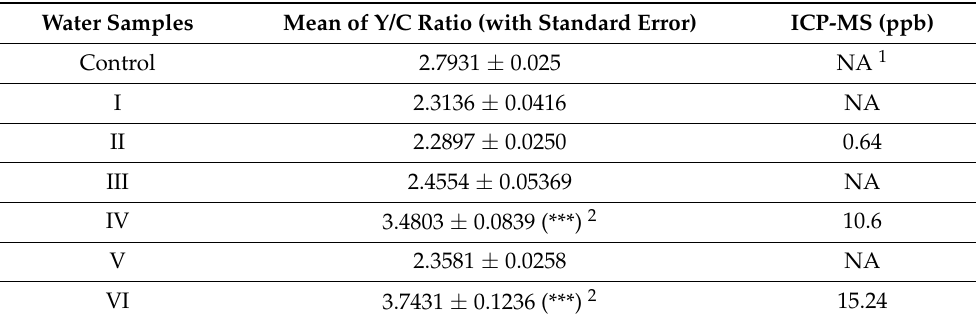
Table 2. Pb detection in different water supply systems. pMet-lead FRET ratios of practical Pb measurements of various sources of water in this study (Figure 6) were validated using the general standard method